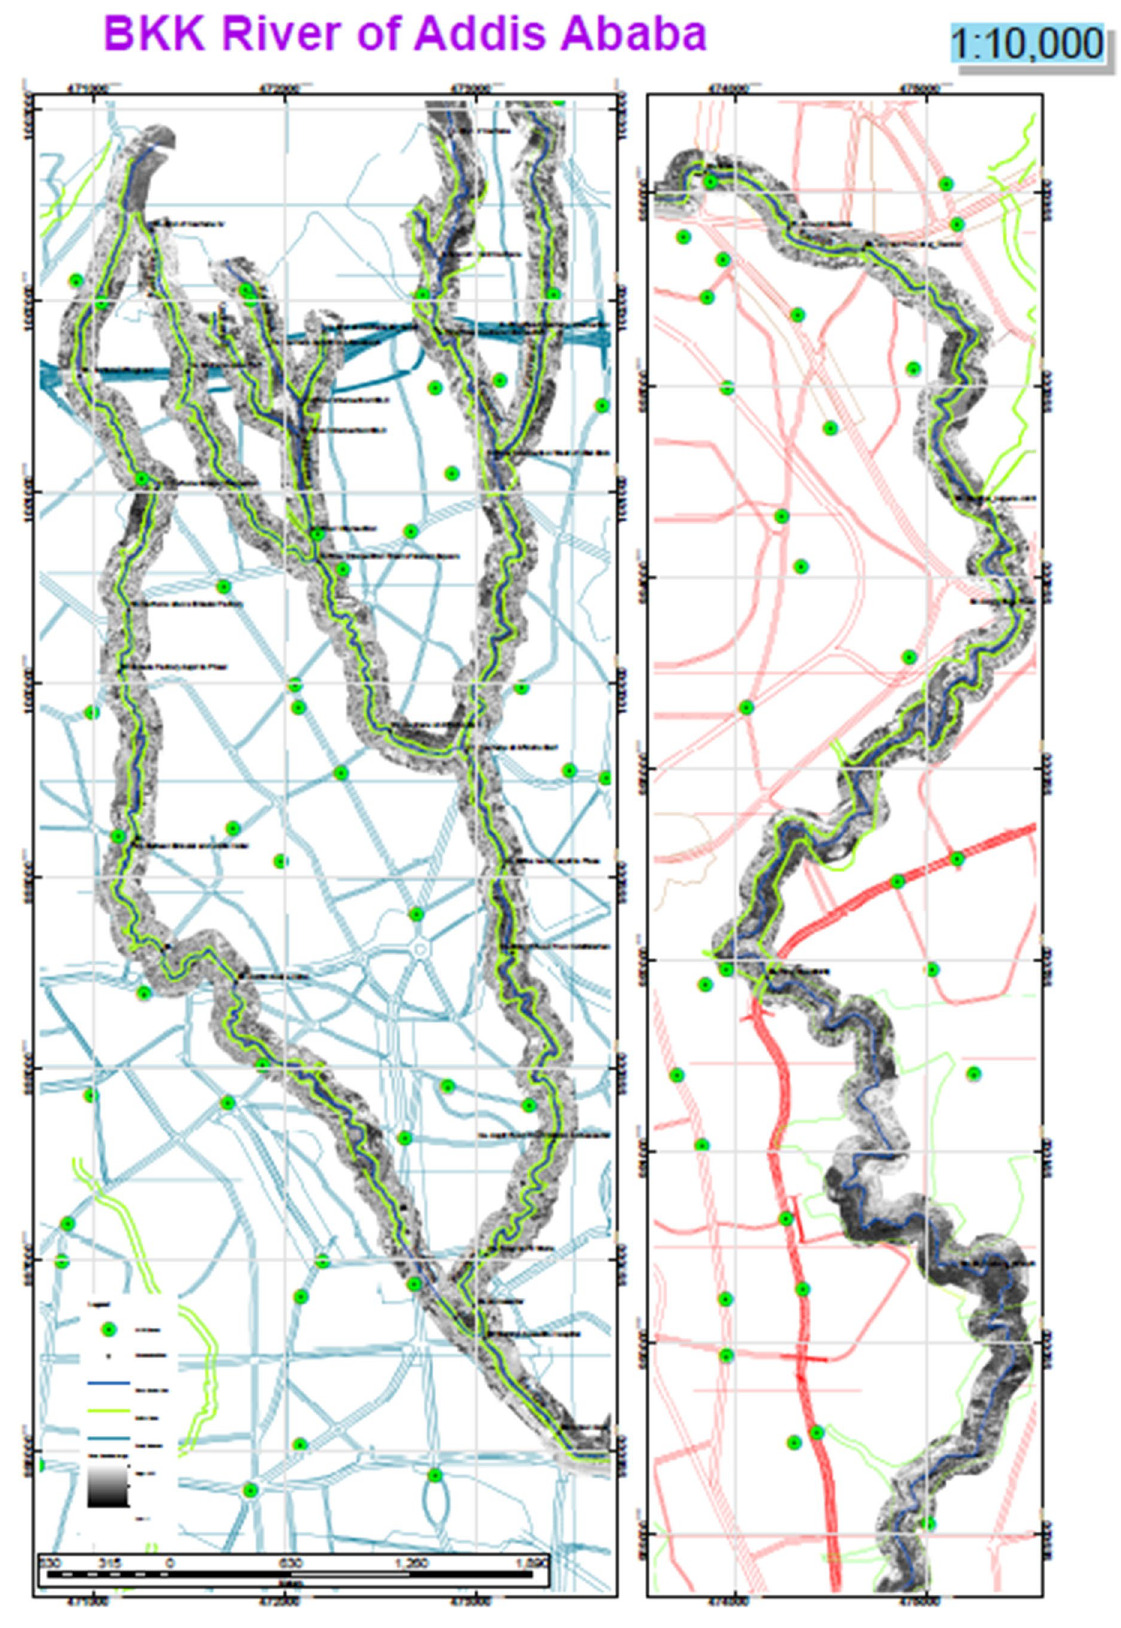
Fig. 6 The whole River Corridor with Road Network. Source Addis Ababa Rivers, Riversides Climate Change Adaptation Project Office 2017a, b,